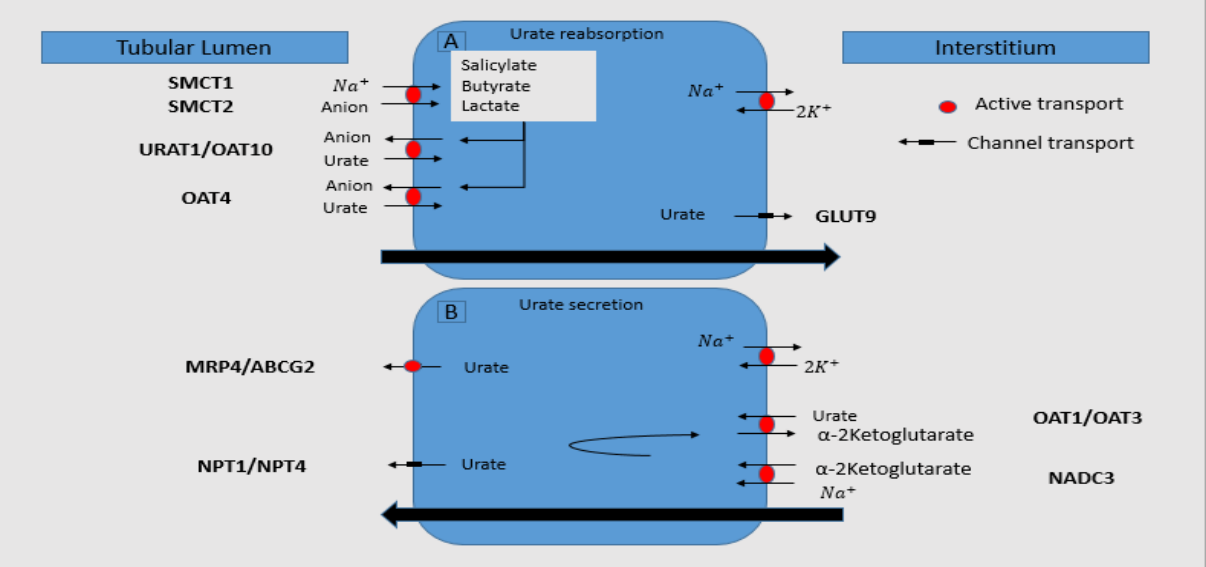
Figure 2. ( A ) SMCT1 and SMCT2 reabsorb Na ‐ dependent anions and raise intra ‐ cellular concentra ‐ tion. URAT1/OAT10/OAT4 exchange intracellular anions with tubular urate, which will exit the cell via GLUT9. ( B ) Na and alpha ‐ ketoglutarate will enter the cell through NADC3. Basolateral OAT1/OAT3 exchanges plasma urate with intracellular alpha ‐ ketoglutarate. Intracellular urate exit is accomplished through voltage channels NPT1/NPT4 or ATP ‐ driven MRP4. SMCT1,sodium ‐ mon ‐ ocarboxylate co ‐ transporter 1; SMCT2, sodium ‐ monocarboxylate co ‐ transporter 2; Na + , sodium; K + , potassium; URAT1, urate transporter 1; OAT10, organic anion transporter 10; OAT4, organic anion transporter 4; OAT1, organic anion transporter 1; OAT3, organic anion transporter 3; MRP4, multi ‐ drug resistance protein 4; ABCG2, adenosine triphosphate binding cassette subfamily G member 2; NPT1, Na ‐ phosphate transporter 1; NPT4, Na ‐ phosphate transporter 4; GLUT9, glucose transporter 9; NADC3, sodium ‐ dependent dicarboxylate cotransporter 3 (Modified after [35]).